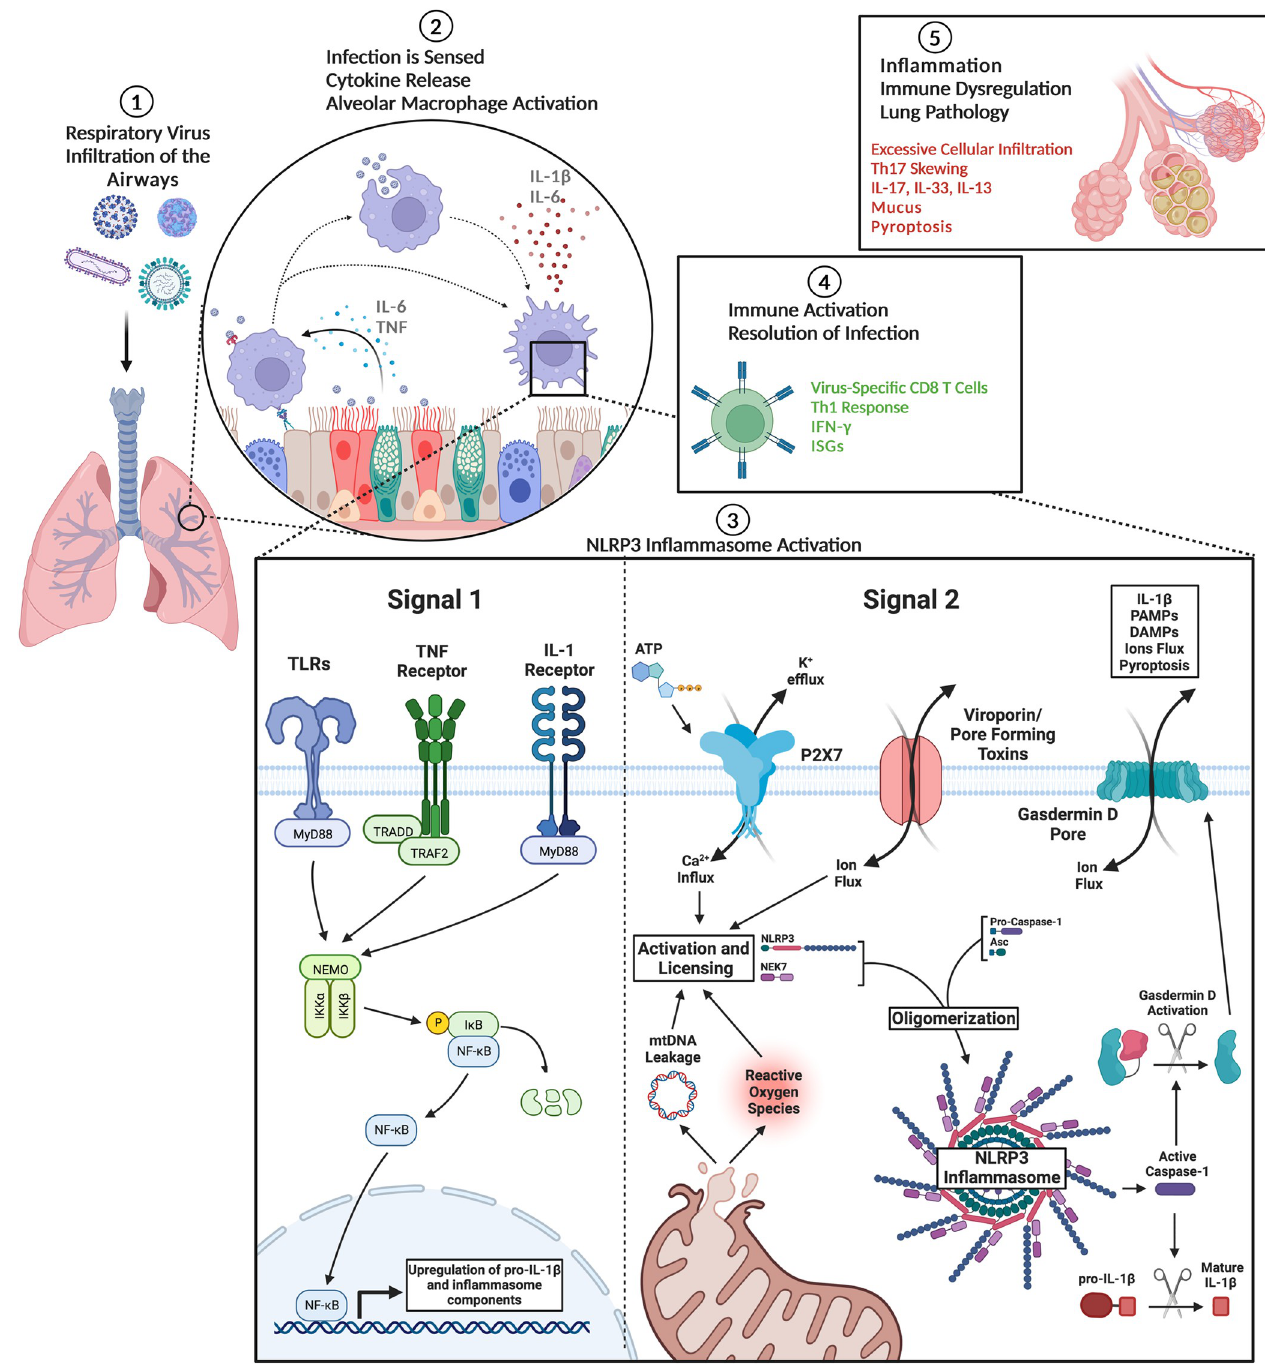
Fig 1. Respiratory virus activation of the NLRP3 Inflammasome. Respiratory viruses enter the airways and come into contact with the respiratory epithelium and alveolar macrophages (1) . Infection and/or recognition of pathogen-associated molecular patterns expressed by the virus activate the innate immune response driving the release of pro-inflammatory cytokines such as IL-1 β (2) . Processing and secretion of IL-1 β requires activation of large multimeric sensors known as the inflammasomes. NLRP3 inflammasome priming requires signal 1 activation of NF- κ B driving the up-regulation of pro-IL-1 β . Signal 2 activation of NLRP3 senses overall cellular stress resulting in changes in cytosolic ion concentration and formation of reactive oxygen species. This initiates binding of NLRP3 with NEK7 that licenses the complex and facilitates oligomerization with the adapter protein, Asc, and inactive pro-caspase-1. Formation of the complex produces cleaved and enzymatically active caspase-1 that can subsequently cleave and activate IL-1 β as well as gasdermin D that forms membrane pores leading to pyroptosis (3) . Activation of the inflammasome is essential for an effective and robust immune response against respiratory viruses (4) . The potency of inflammasome activation can be a “double-edged sword” when left unrestrained leading to severe immunopathology (5) . Graphics are the authors’ original work created with BioRender.com.